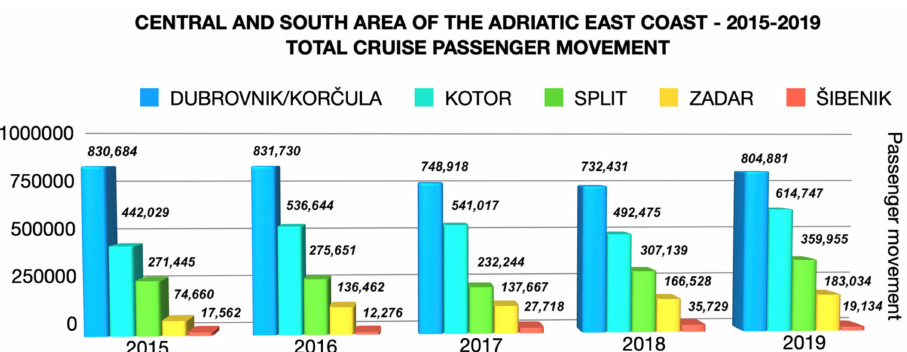
Figure 5. Total cruise passenger movement from 2015 to 2019 in five leading ports in the central and south part of the Adriatic east